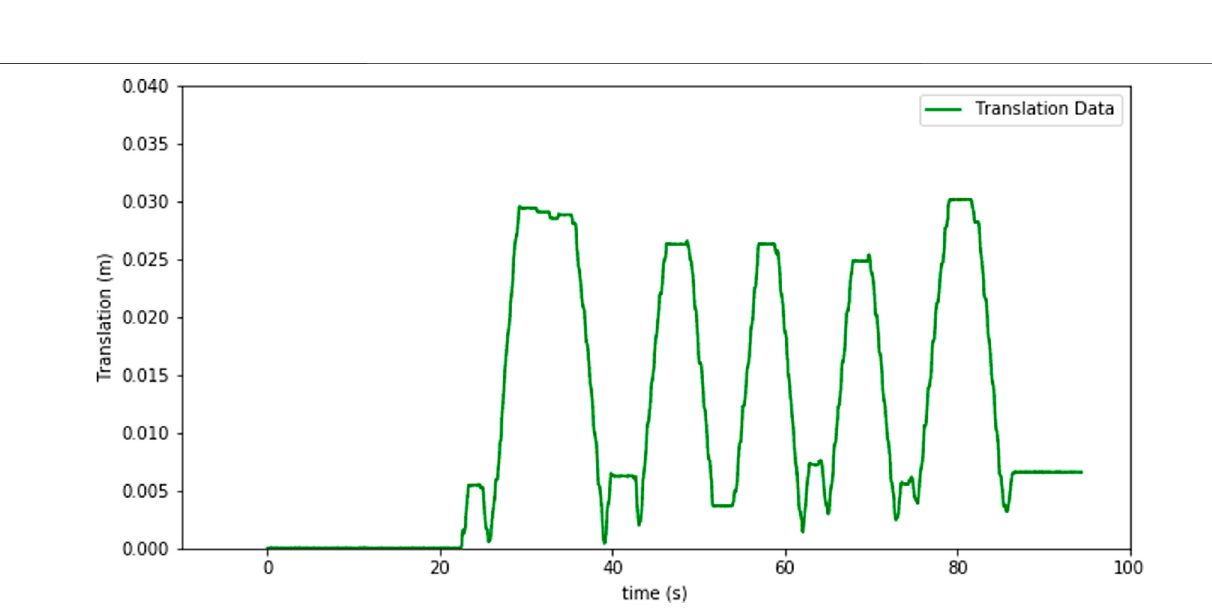
FIGURE 8 | Tool-tip position over